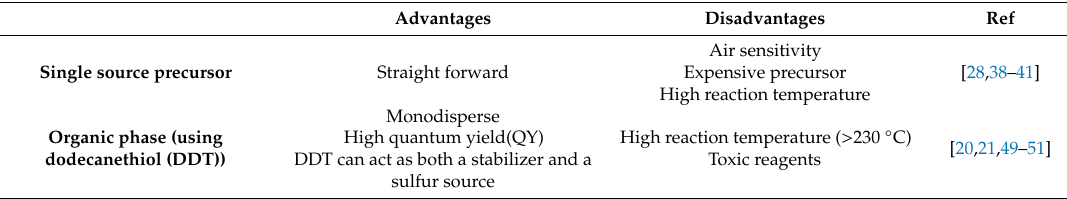
Table 1. The main synthetic strategies involved in the production of CuInS 2 (CIS)-based quantum dots (QDs).